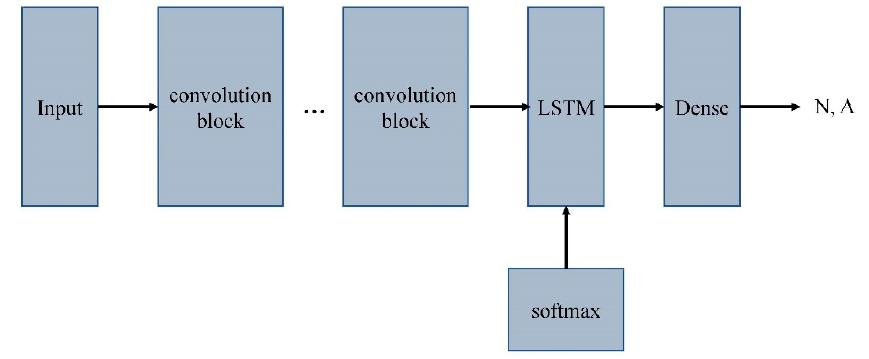
Figure 9. The overall architecture of 8CSL.